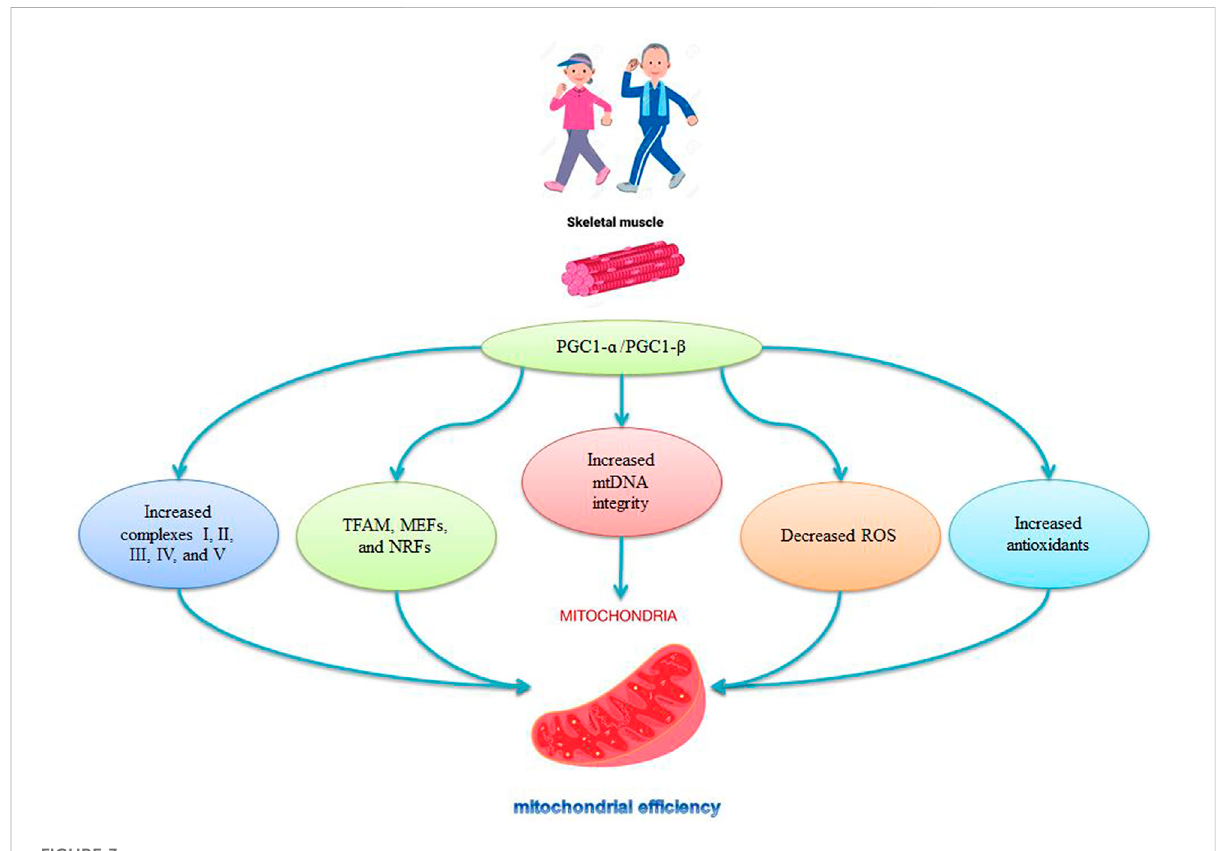
FIGURE 3 Role of PGC-1 ɑ in mitochondrial regulation by